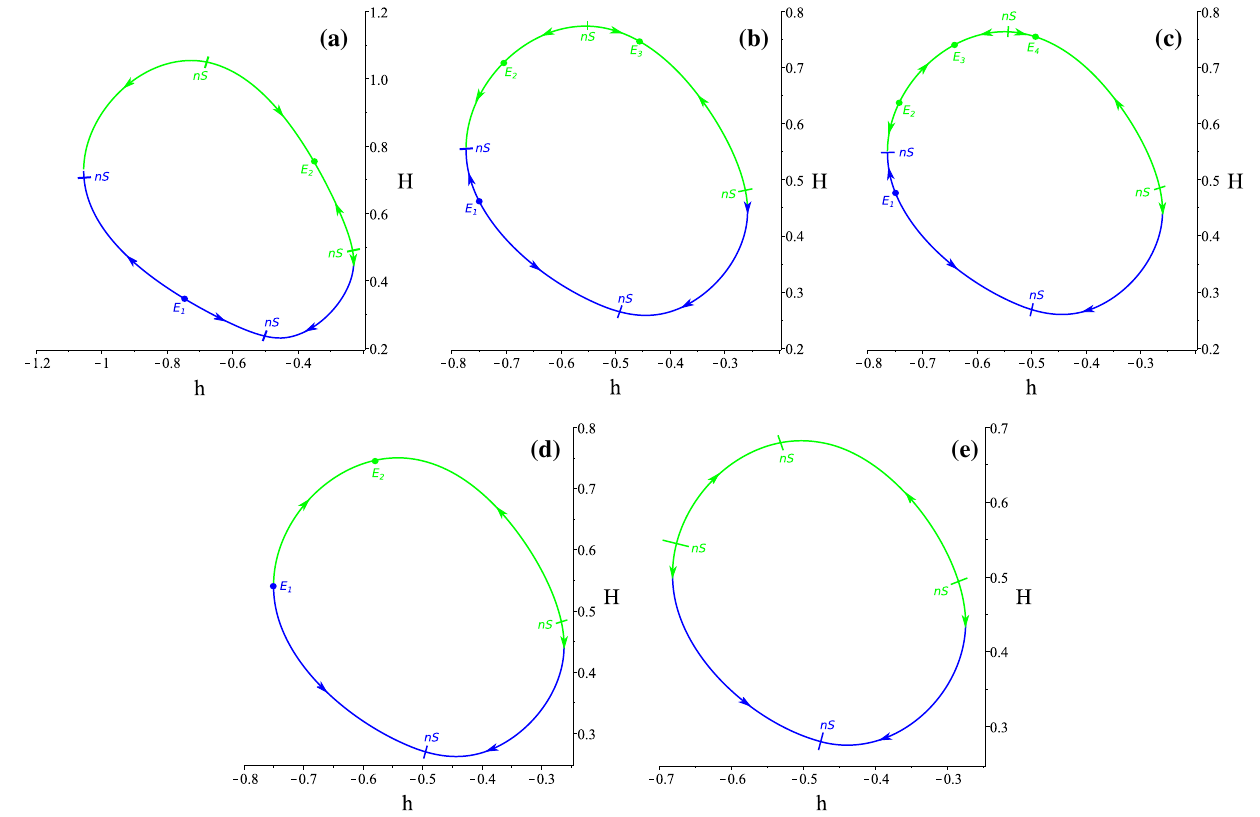
Fig. 7 The fine structure of the solutions in the α > 0, β > 0 case: correspond to the different branches (blue – to H 2 and green – to H 3 , in μ < 1 / 6 on a panel, μ = 1 / 6 on b panel, μ > μ > 1 / 6 on c panel, accordance with the designation in Fig. 1) (see the text for more 3 . 3 > μ > μ μ = μ 3 on d panel and 0 3 on e panel. Different colors